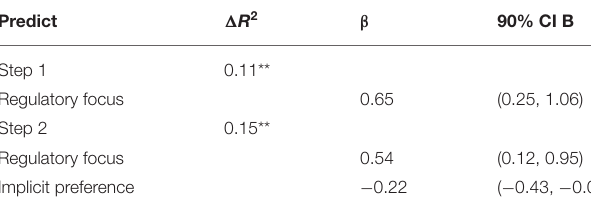
TABLE 2 | Sequence of blocks for the IAT experiment. TABLE 3 | Results of the regression analysis predicting information